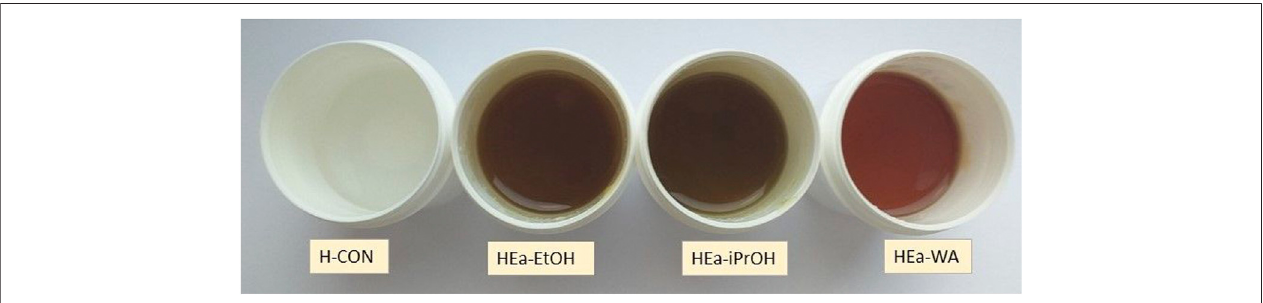
FIGURE 1 | The hydrogels used in the study. HEa-EtOH — hydrogel containing dry ethanolic extract of E. angustifolium ; HEa-iPrOH, hydrogel containing dry isopropanol extract of E. angustifolium ; HEa-WA, hydrogel containing dry water extract of E. angustifolium ; H – CON, hydrogel without E. angustifolium extract.